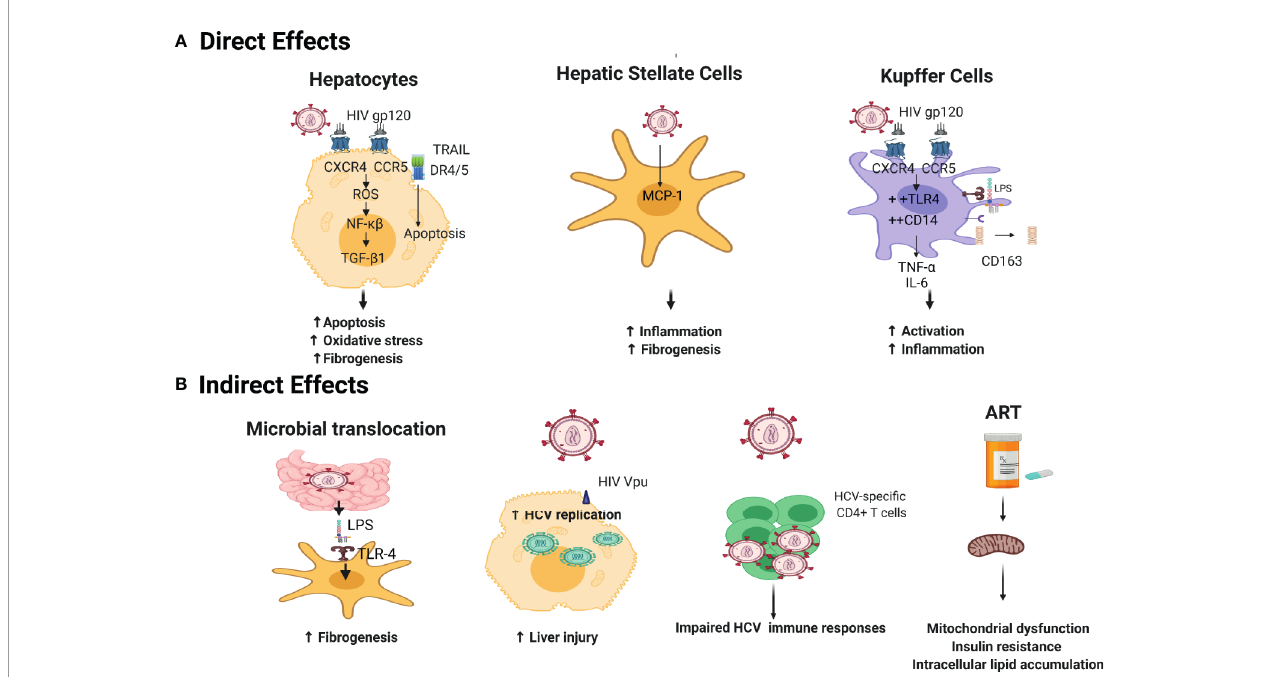
FIGURE 1 | Mechanisms underlying acceleration of liver disease progression by HIV in HCV/HIV coinfection. (A) Direct Mechanisms: gp120 binds to HIV coreceptors (CXCR4 and CCR5) on hepatocytes surface (157) leading to accumulation of ROS which triggers an NF- kb mediated oxidative stress (158, 159). HIV also activates TNF – related apoptosis-inducing ligand (TRAIL)-mediated apoptosis via upregulation of TRAIL receptor 1 (DR4), and 2 (DR5) (160), aggravating HCV fi brotic complications (161). HIV promotes hepatic stellate cells (HSC) collagen I expression and secretion of the proin fl ammatory cytokine monocyte chemoattractant protein-1 (MCP-1) inducing in fl ammation and fi brogenesis (162). HIV sensitizes Kupffer cells to lipopolysaccharide (LPS) via gp120 binding to CXCR4 and CCR5 (163) increasing cell surface expression of CD14 and TLR4, resulting in increased secretion of TNF- a and IL-6 (164). This is accompanied by shedding of CD163 in serum (165). (B) Indirect Mechanisms: HIV indirectly augments fi brosis mainly by microbial translocation: LPS translocate through impaired gut epithelium (105) and binds to Toll-like receptor 4 TLR4 on HSCs, leading to upregulated chemokine secretion and Kupffer cells chemotaxis (166). HIV accessory proteins Vpr (167) and Nef (168) enhance HCV RNA replication creating a state of in fl ammation and tissue damage. HIV causes functional alterations of HCV-speci fi c immune responses with more HCV replication and hepatic in fl ammation (150, 169). ART elicits insulin resistance by altering mitochondrial function (170, 171) and increased intracellular lipid accumulation (172, 173) leading to enhanced development of liver fi brosis (174). Created with